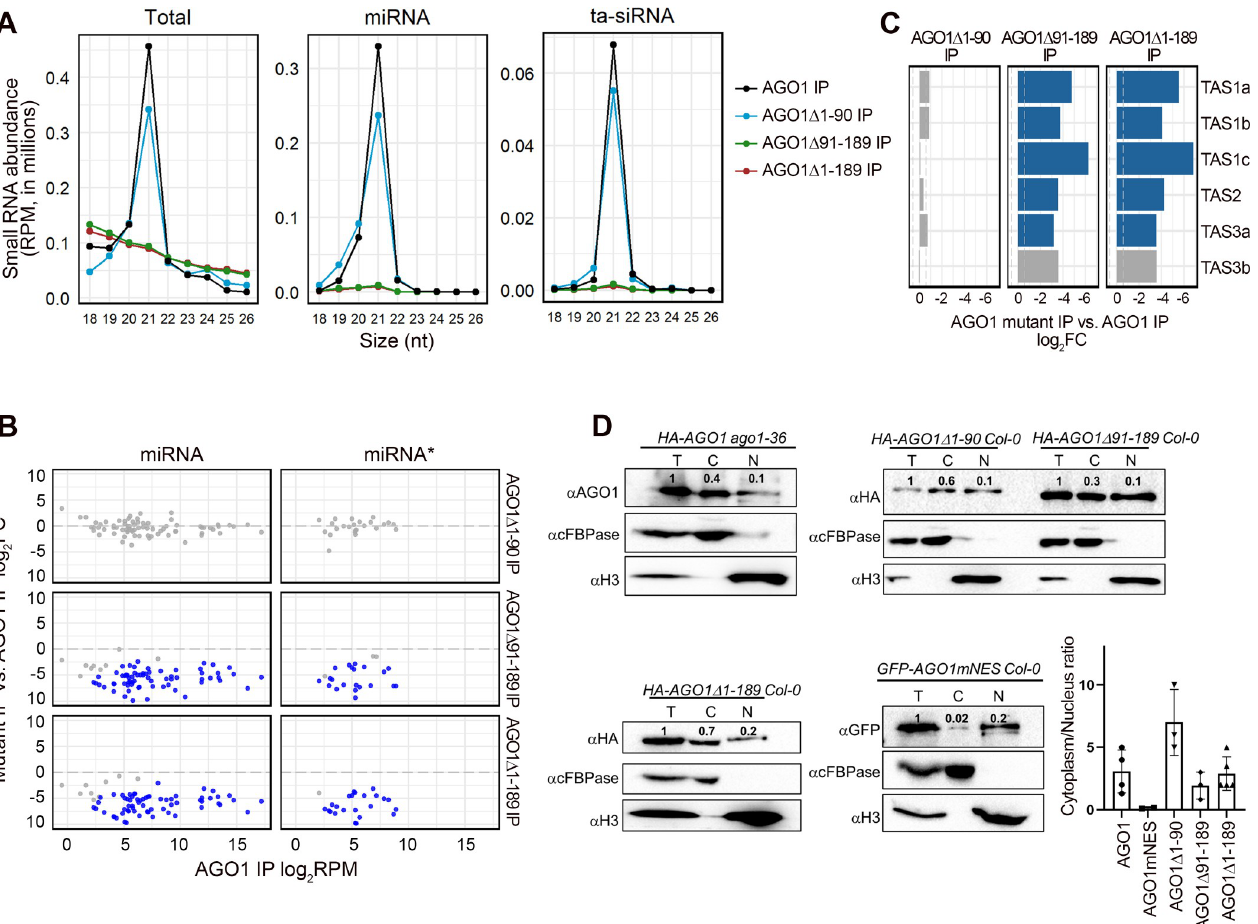
Fig 3. The loading of miRNAs and ta-siRNAs into AGO1 is affected by truncations of the AGO1 N-terminal extension. (A to C) Analysis of small RNA- seq data of AGO1-associated small RNAs. Wild-type AGO1 and AGO1 Δ 1–90 were in the ago1-36 background, while other AGO1 NTE-truncated forms were in the ago1-36/+ background. Two biological replicates of each genotype were included in the analysis. (A) Size (in nucleotides (nt)) distribution depicting the abundance of 18- to 26-nt small RNAs in AGO1 immunoprecipitates (IP) from plants containing AGO1 and AGO1 NTE-truncated forms. Total small RNAs, miRNAs and ta-siRNAs are shown. RPM, reads per million (see Methods). (B) Scatter plots showing the miRNAs and miRNA � s with significantly different levels (fold change > 1.5 and adjust P value < 0.01) between IP-ed AGO1 mutants and AGO1. Red dots denote miRNAs or miRNA � s with significantly higher abundance, while blue dots denote miRNAs or miRNA � s with significantly lower abundance. (C) Bar plots depicting the log 2 (fold change) of 21-nt ta-siRNAs between IP-ed AGO1 NTE-truncated forms and AGO1. Blue bars denote ta-siRNAs with significantly lower levels (fold change > 1.5 and adjust P value < 0.01). (D) Quantification of the nuclear-cytoplasmic partitioning of AGO1. Western blots were performed with various genotypes as indicated. Blots were probed using AGO1, HA, or GFP antibodies to detect AGO1. Histone H3 is a nuclear marker and used to quantify AGO1 in the total lysate (T) and the nuclear fraction (N). cFBPase is a cytoplasmic marker and used to quantify AGO1 in the T and the cytoplasmic fraction (C). The numbers above the bands represent relative protein levels. Bar plots summarize results of cytoplasmic/nuclear ratios of AGO1 from several experimental repeats shown here and in S7 Fig. Two replicates of wild-type AGO1 and two replicates of AGO1 Δ 1–90 were in the ago1-36 background, AGO1mNES was in the Col background, while other AGO1 NTE-truncated mutants, two replicates of AGO1 Δ 1–90, and two replicates of wild-type AGO1 were in the Col-0 background. Error bars indicate